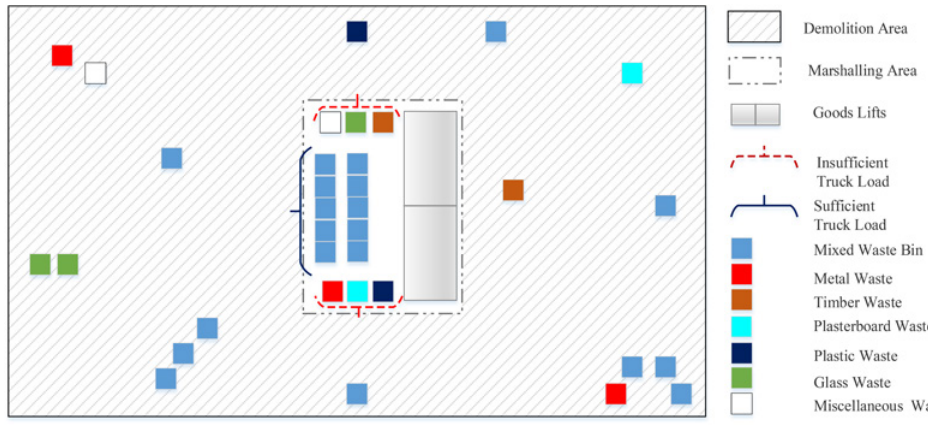
Stage 2: Marshalling